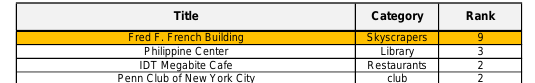
Figure 4. The route and area where the experiment is performed with P3, P5 and P12 search points (source: Google Maps)